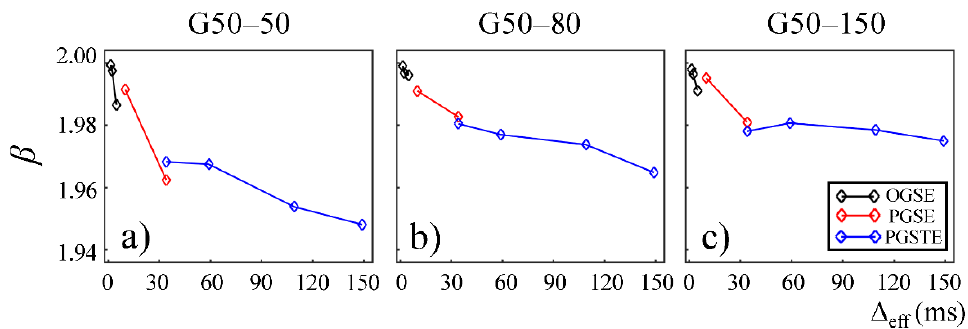
Figure 8. Plot of spatial fractional order ( β ) versus effective diffusion time, Δ eff , for gels G50 – 50 ( a ), G50 – 80 ( b ), and G50 – 150 ( c ). The data acquired by using the OGSE, PGSE, and PGSTE pulse sequences are marked in black, red, and blue, respectively.